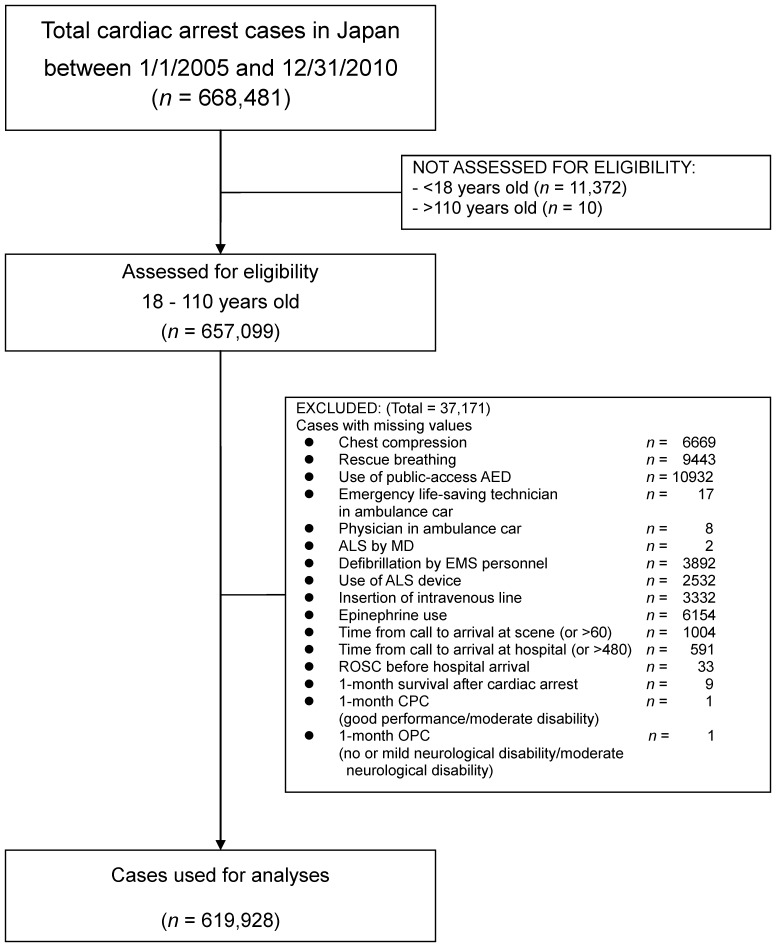
OHCA cases included in the study.